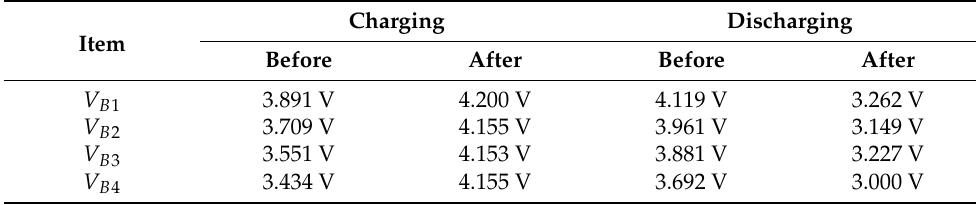
Table 7. Battery voltages while charging and discharging. Charging Discharging Item Before After Before